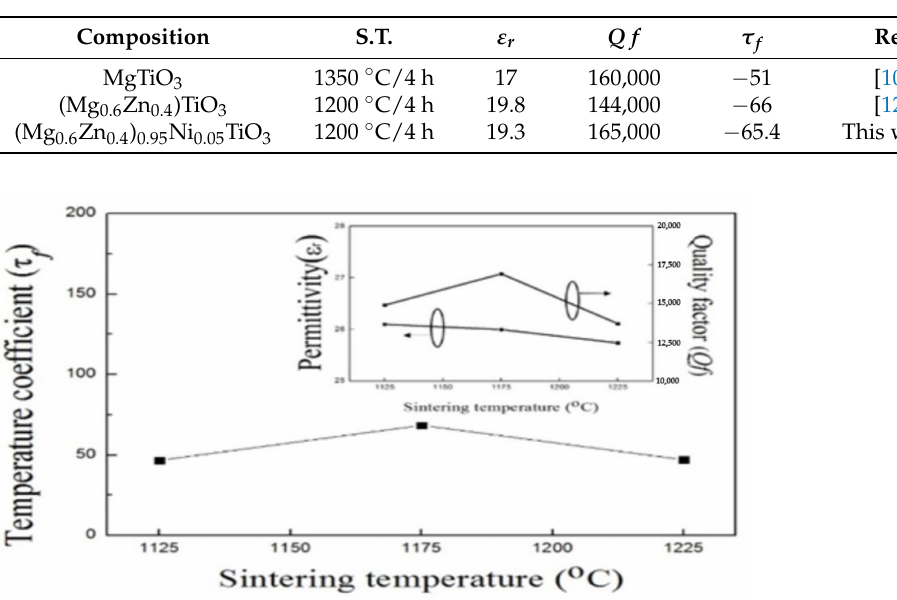
Table 3. Comparison of the proposed dielectric with other similar documented dielectric ceramics.